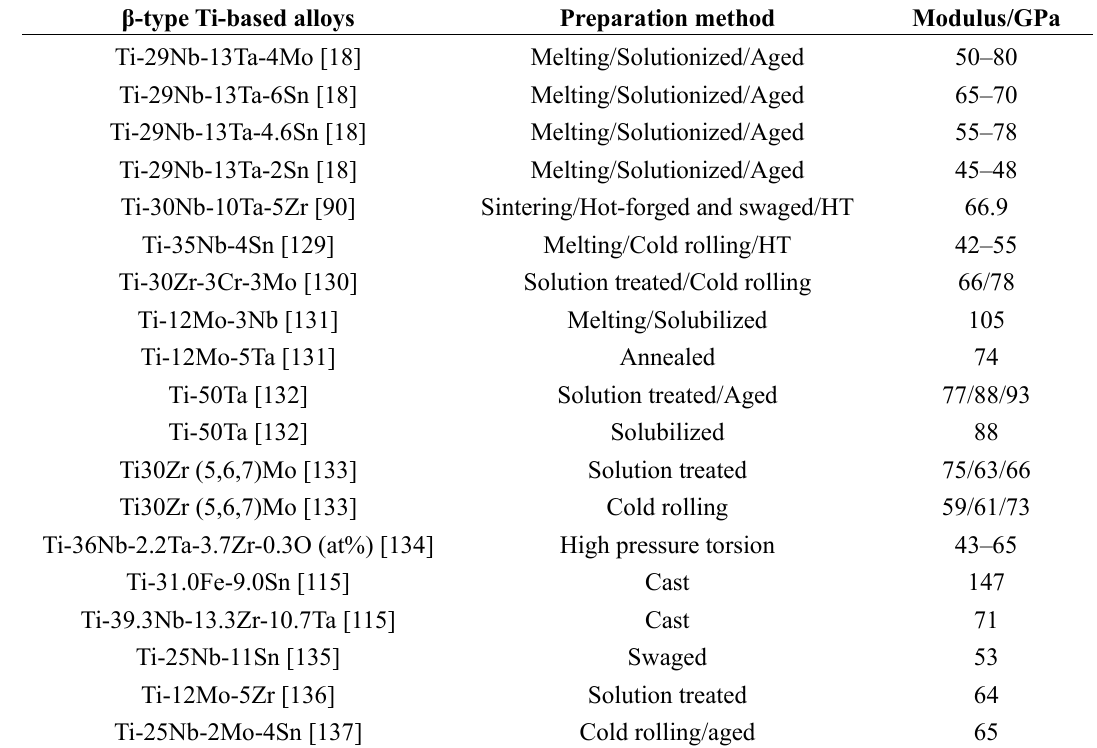
Table 5. Selected low modulus β -type Ti-based alloys newly developed for biomedical applications. β -type Ti-based